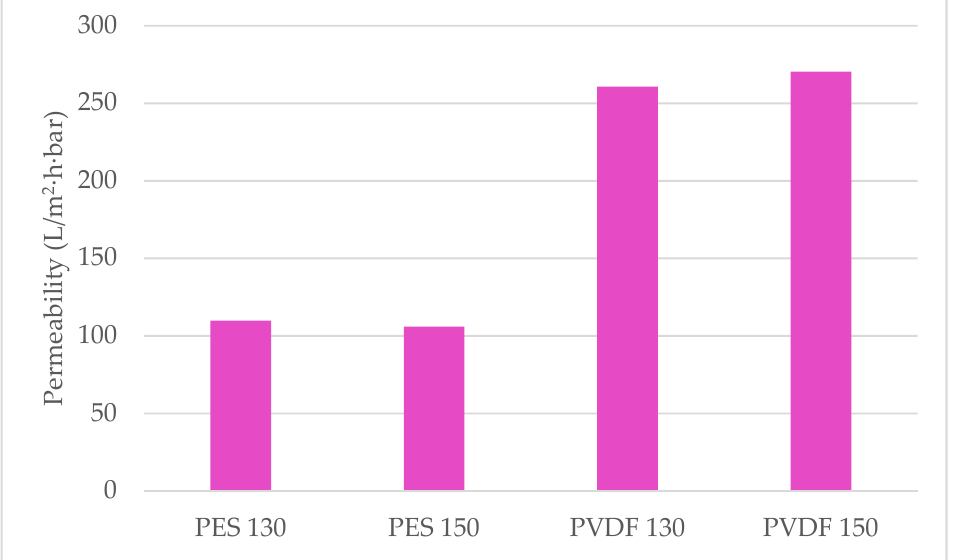
Figure 10. Permeability of membranes.